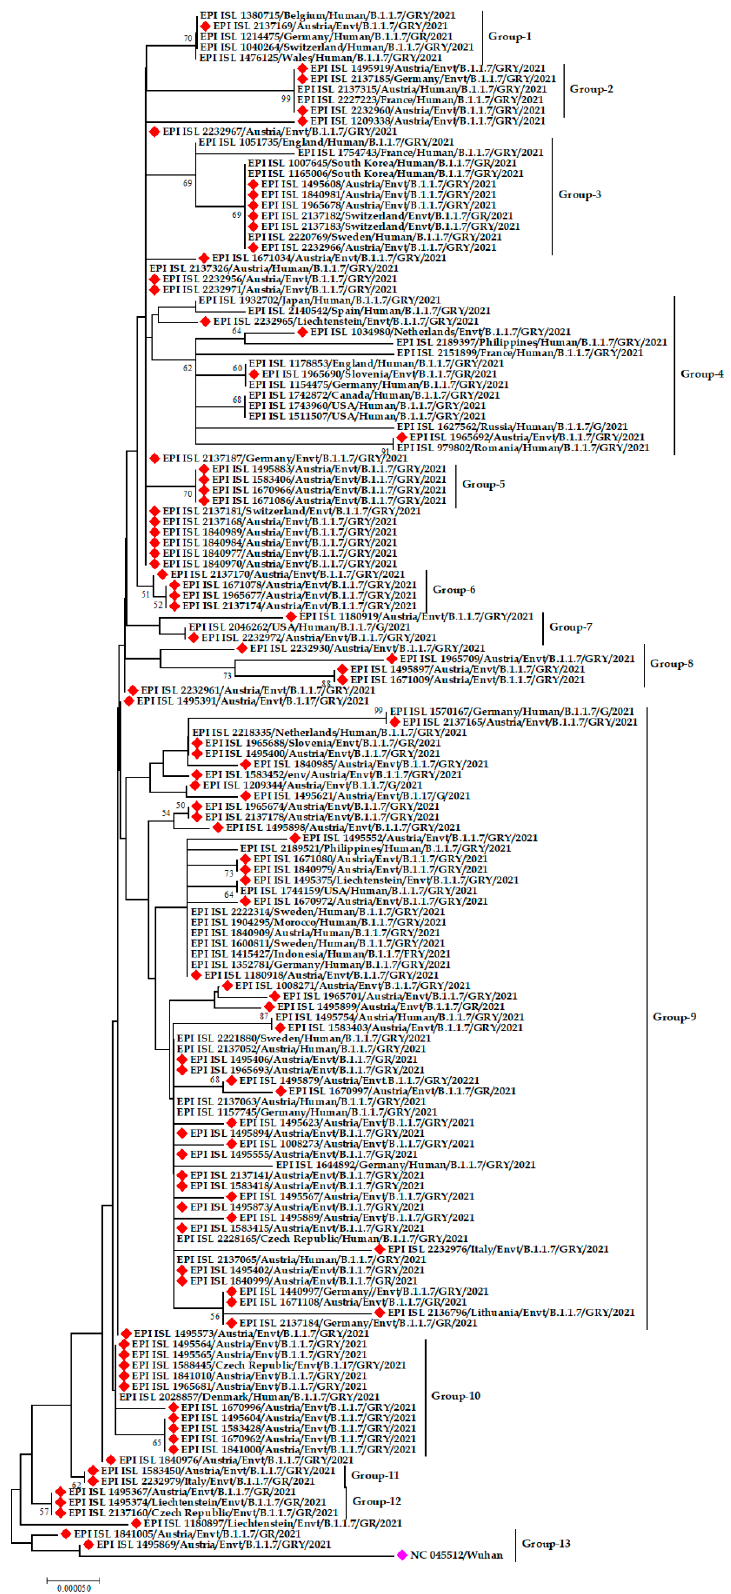
Figure 4. Phylogenetic analysis of α variant, B.1.1.7 lineage of SARS-CoV-2 environmental strains. Red color denotes the environmental alpha variants, fuchsia pink color refers to the reference sequence from Wuhan, China.